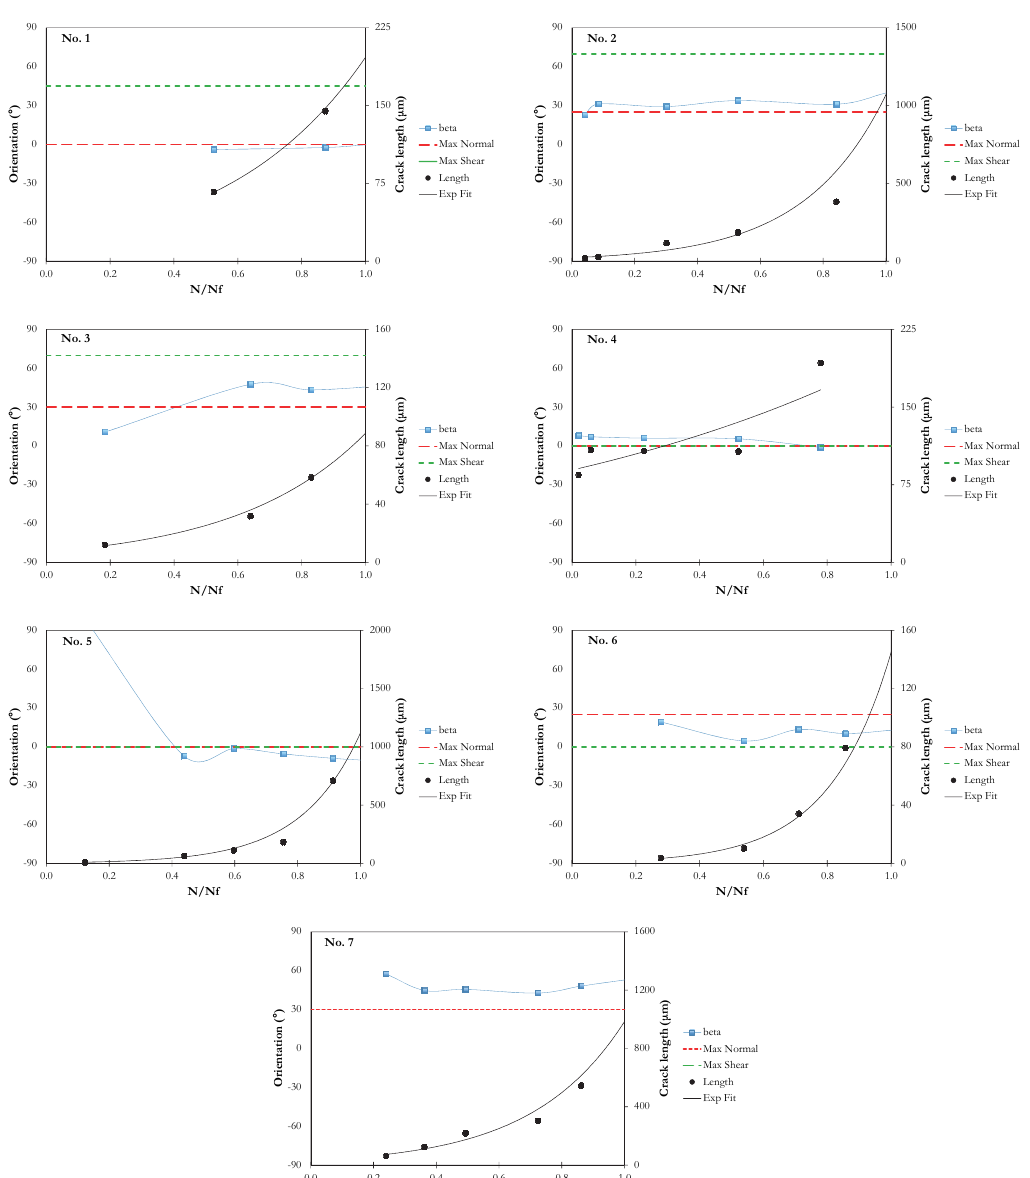
Figure 2: Variations of projected angle β and crack length with cycling. Planes of maximum normal and maximum shear strains are indicated by red-dashed and green-dashed lines,